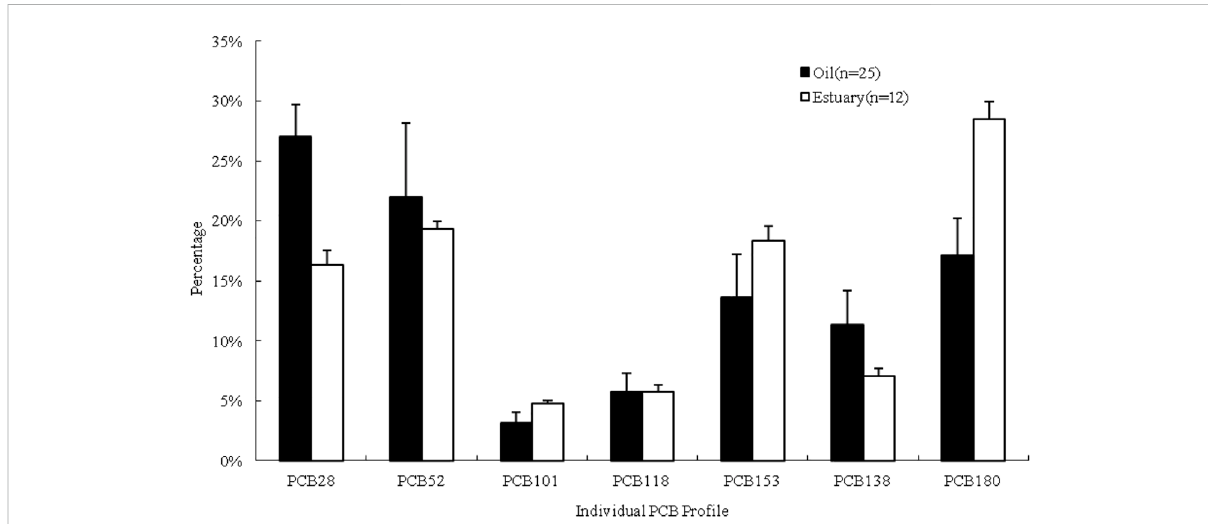
FIGURE 3 Proportions of individual congeners in total PCBs in oil soil and estuarine soil samples.